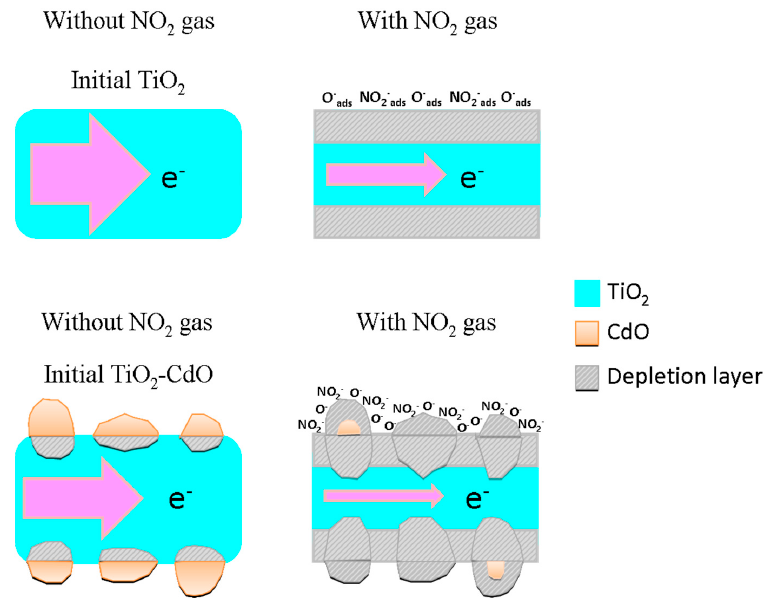
Figure 9. A schematic of gas sensing mechanisms for the TiO 2 and TiO 2 –CdO rods on exposure to NO 2 gas. The size of arrows represented the current degree in the TiO 2 .